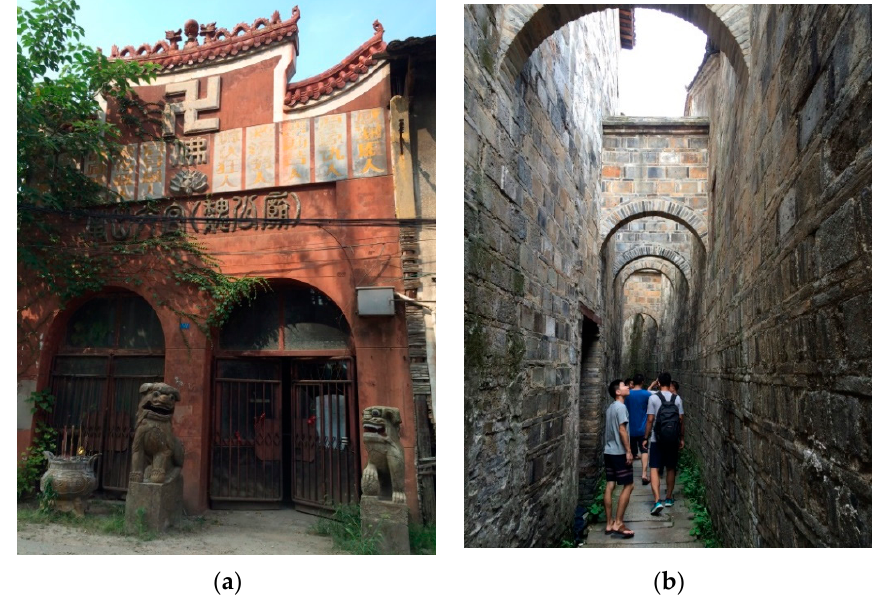
Figure 2. A traditional gorge in central China. ( a ) Front view of the temple; ( b ) Front view of the street.